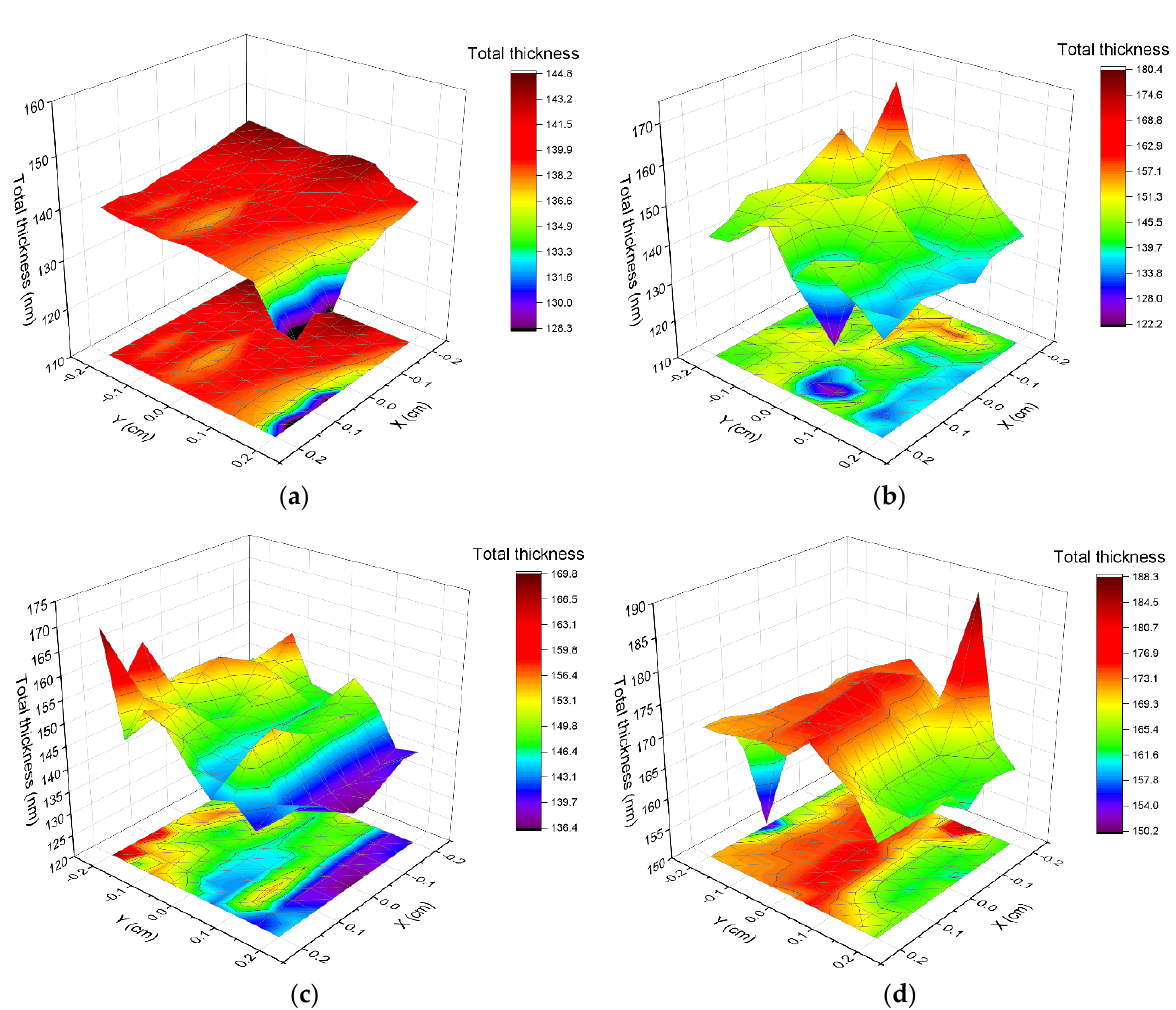
Figure 6. Total thickness parameter calculated for maps of Cu 2 O samples ( a ) non-implanted, ( b ) dose 1, ( c ) dose 2, and ( d ) dose 3.